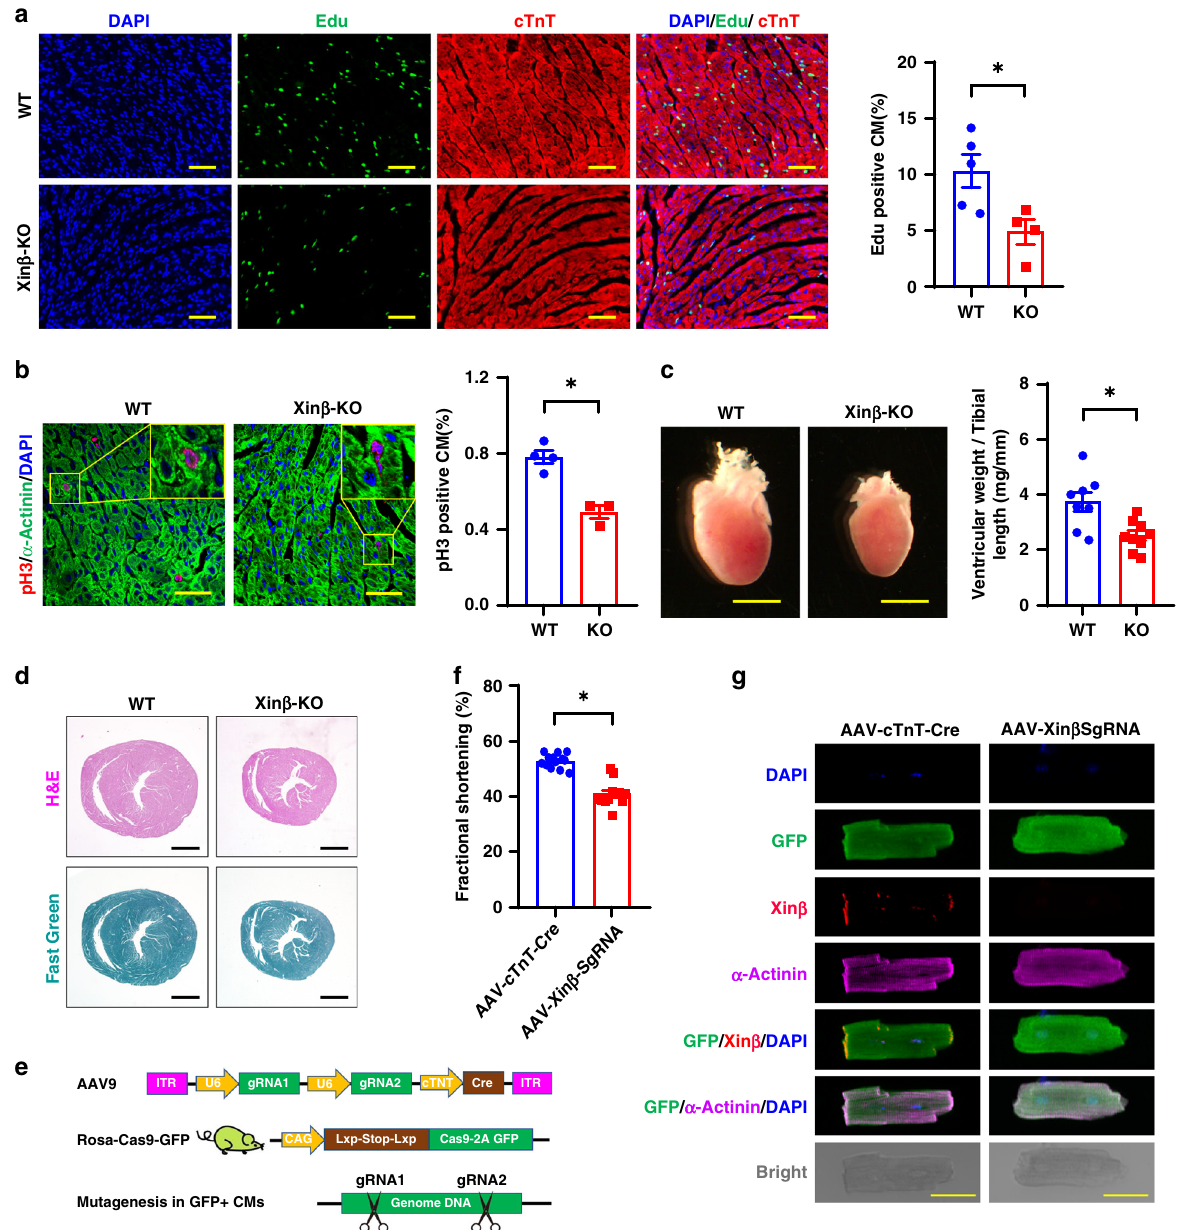
Fig. 2 Decreased cardiomyocyte proliferation in Xin β KO hearts. a Edu incorporation in P7.5 Xin β KO and control hearts. DAPI marks nuclei, cTnT labels cardiomyocytes. Quanti fi cation in right panel. Scale bars = 100 µ m. N = 4 and 5 biologically independent samples, respectively, * P <0.05. b pH3 staining of P7.5 Xin β KO and control hearts. DAPI marks nuclei, α -actinin labels cardiomyocytes. Quanti fi cation in right panel. Scale bars = 40 µ m. N = 4 and 3 biologically independent samples, respectively, * P <0.05. c Heart morphology (left panel) and ventricle weight vs. tibial length ratio (right panel) of P7.5 Xin β KO and control hearts. Scale bars = 2mm. N = 9 and 8 biologically independent samples, respectively,* P <0.05. d Hematoxylin and eosin (red) and Fast Green (green) staining of p7.5 Xin β KO and control hearts. Scale bars = 1mm. e AAV9-based CRISPR/Cas9 strategy to mutate the Xin β gene in postnatal mouse hearts; f percent fractional shortening (FS) change in 4-week-old AAV- cTnT-Cre and AAV- Xin β -sgRNA -treated mice. N = 13 and 12 biologically independent samples, respectively, * P <0.05. g Morphology and immunostaining of isolated cardiomyocytes from hearts of adult Xin β KO and control mice. Scale bars = 50 µ